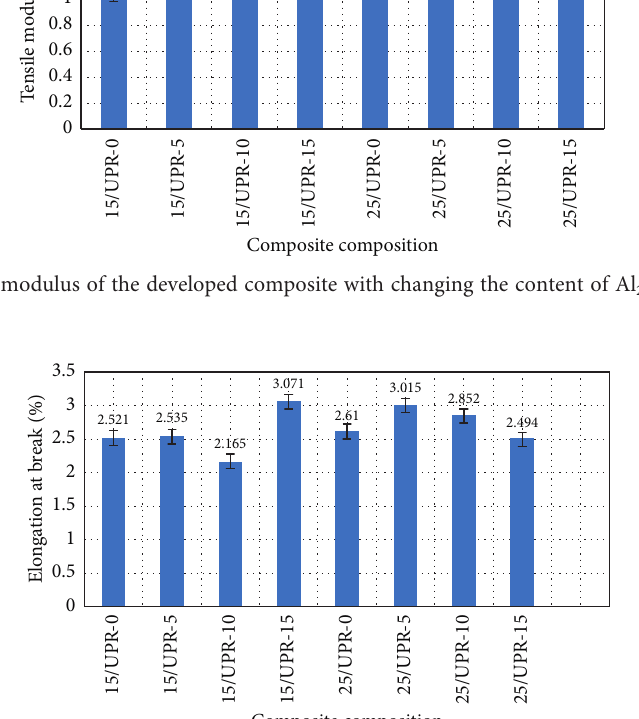
Figure 4: The variation of breaking elongation of the developed composite with changing the content of Al